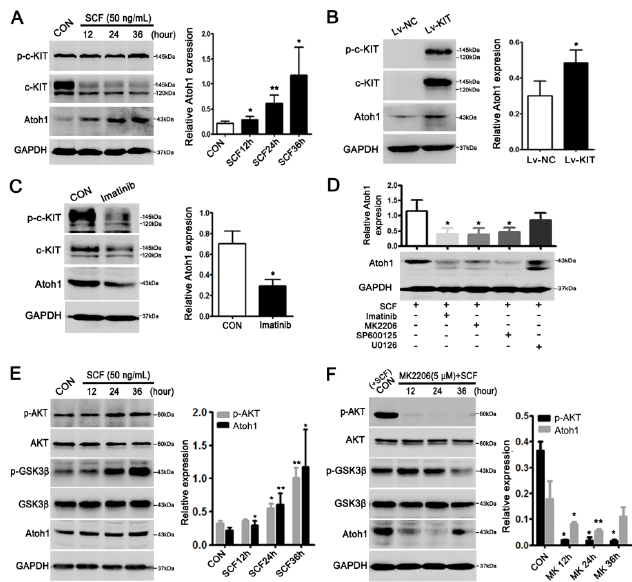
Figure 3. Stem cell factor (SCF)/c-KIT signaling upregulated Atoh1 via Protein Kinase B (AKT) and c-Jun N-terminal kinase (JNK) pathways in LS174T cell. ( A ) Activation of c-KIT by exogenous recombinant human stem cell factor (rhSCF) (50 ng/mL) treatment enhanced Atoh1 expression in a time-dependent manner, * p < 0.05, ** p < 0.01; ( B ) overexpression of c-KIT by lentivirus encoding c-kit clearly upregulated Atoh1 in the presence of rhSCF. Lv-NC, lentivirus-control; Lv-KIT, lentivirus- c-kit ; * p < 0.05 ( C ) Imatinib treatment (2 µ M) for 24 h to inhibit SCF/c-KIT signaling evidently attenuated Atoh1 expression, * p < 0.05; ( D ) CRC cells were exposed to rhSCF alone or in combination with MK2206 (AKT inhibitor), SP600125 (JNK inhibitor), or U0126 (extracellular signal-regulated kinases (ERK) inhibitor). MK2206 or SP600125 treatment could significantly abrogate the rhSCF-induced Atoh1 expression, * p < 0.05; ( E ) activated c-KIT-AKT signaling pathway by rhSCF could up-regulate p-GSK3 β , which, thereby, increased Atoh1. * p < 0.05, ** p < 0.01; and ( F ) inhibiting AKT by MK2206 treatment significantly downregulated p-GSK3 β and Atoh1. Cells with rhSCF treatment were used as control, * p < 0.05, ** p < 0.01. All the values are mean ± SEM of three independent experiments